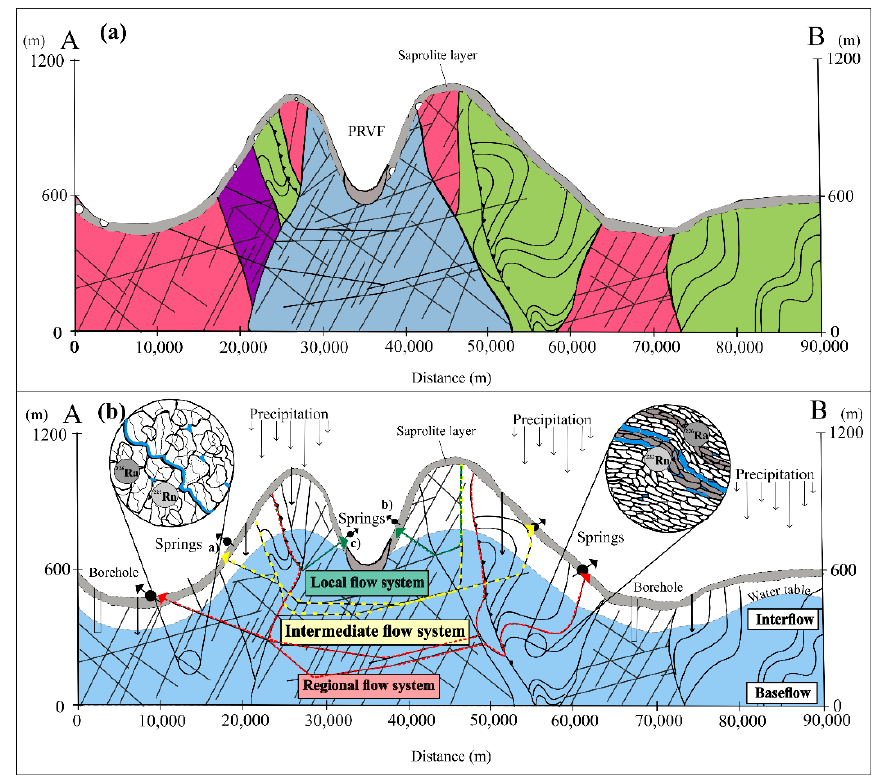
Figure 2. A hydrogeological conceptual model for radon contamination in groundwater of the studied region. ( a ) Geologic section profile with tectonic structures like thrust faults, faults and shear zones and fault-joint / fault-lineament types faults; ( b ) main tectonic structures with a microscopic overview of radon transfer from metasedimentary and granitic rocks to groundwater. A detailed description of model premises is provided in Section 3.2.